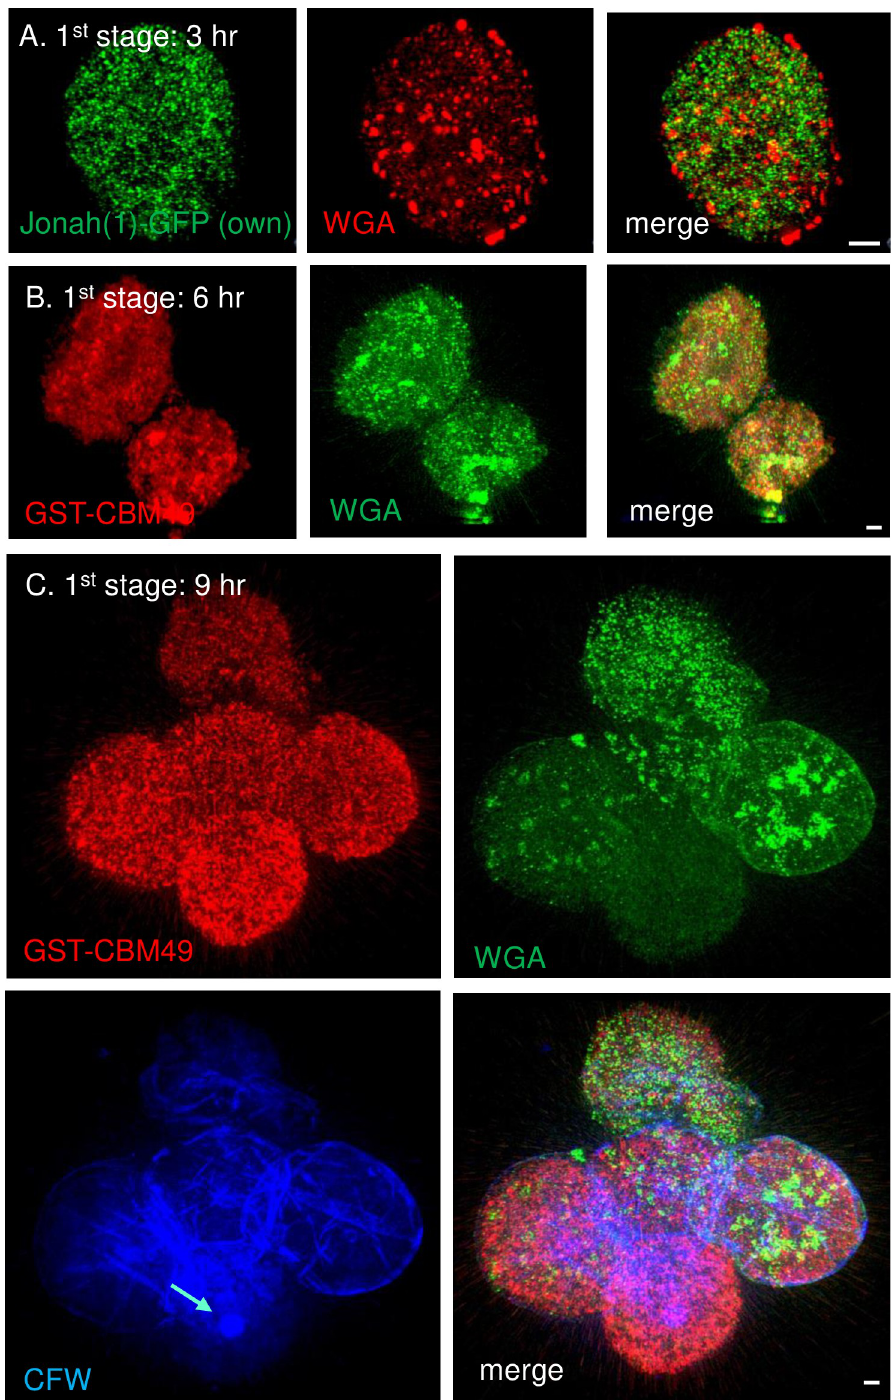
Fig 4. During the first stage of encystation, SIM showed Jonah(1)-GFP and glycopolymers labeled by WGA and GST-CBM49 were present in dozens of distinct vesicles. A. After 3 hr encystation, Jonah(1)-GFP (green), which was expressed under its own promoter, was present in dozens of small vesicles. WGA (red) labeled fewer but larger vesicles, which did not overlap with those containing Jonah(1)-GFP (see merge). B. After 6 hr encystation, glycopolymers labeled by GST-CBM49 (red) were present in dozens of vesicles that did not overlap with those labeled by WGA (green). C. After 9 hr encystation, glycopolymers labeled with GST-CBM49 and WGA were again very abundant in vesicles that did not overlap. CFW was not visible in vesicles of organisms encysting for 3 to 6 hr, but CFW